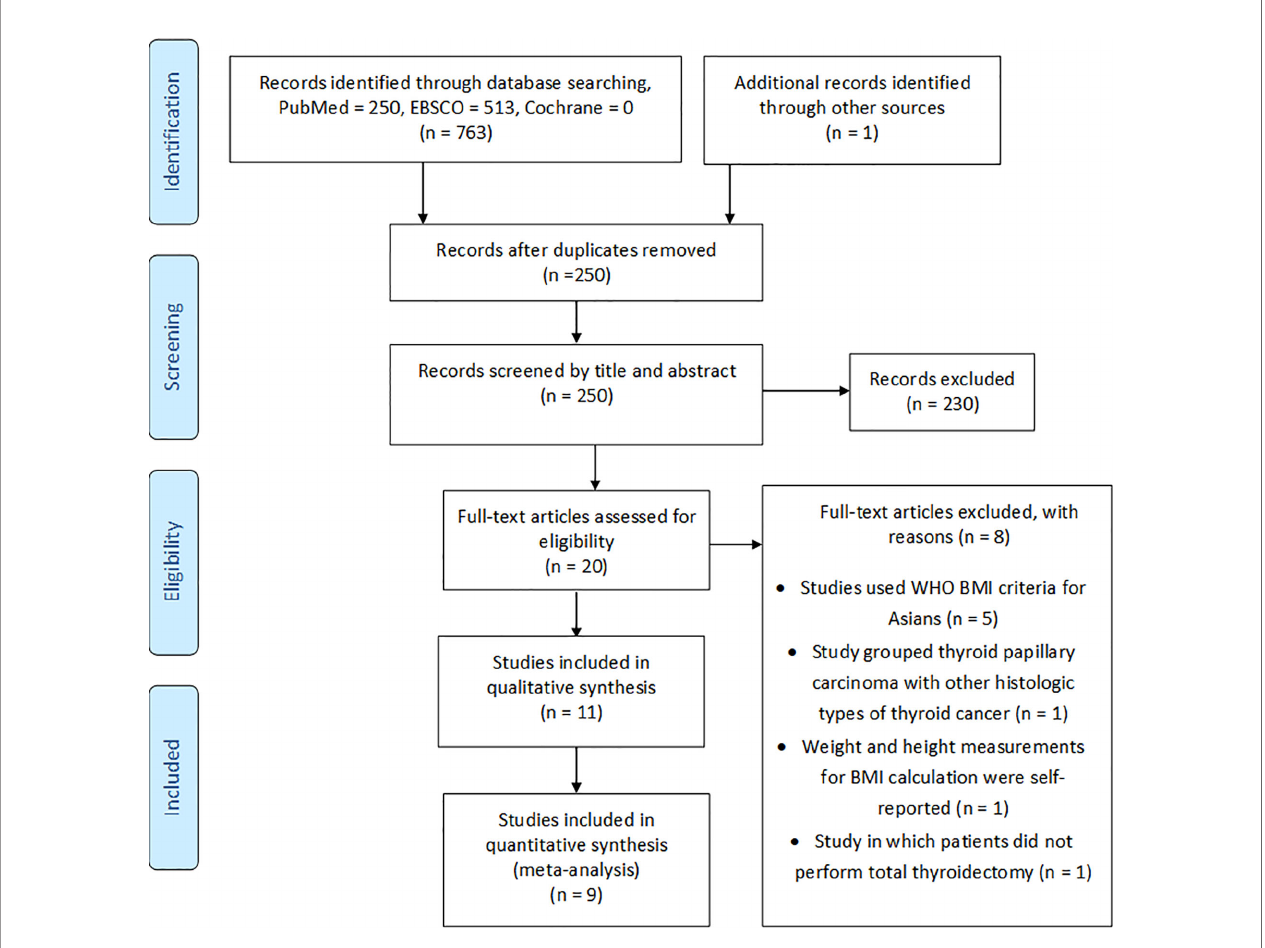
FIGURE 1 | Study selection fl ow